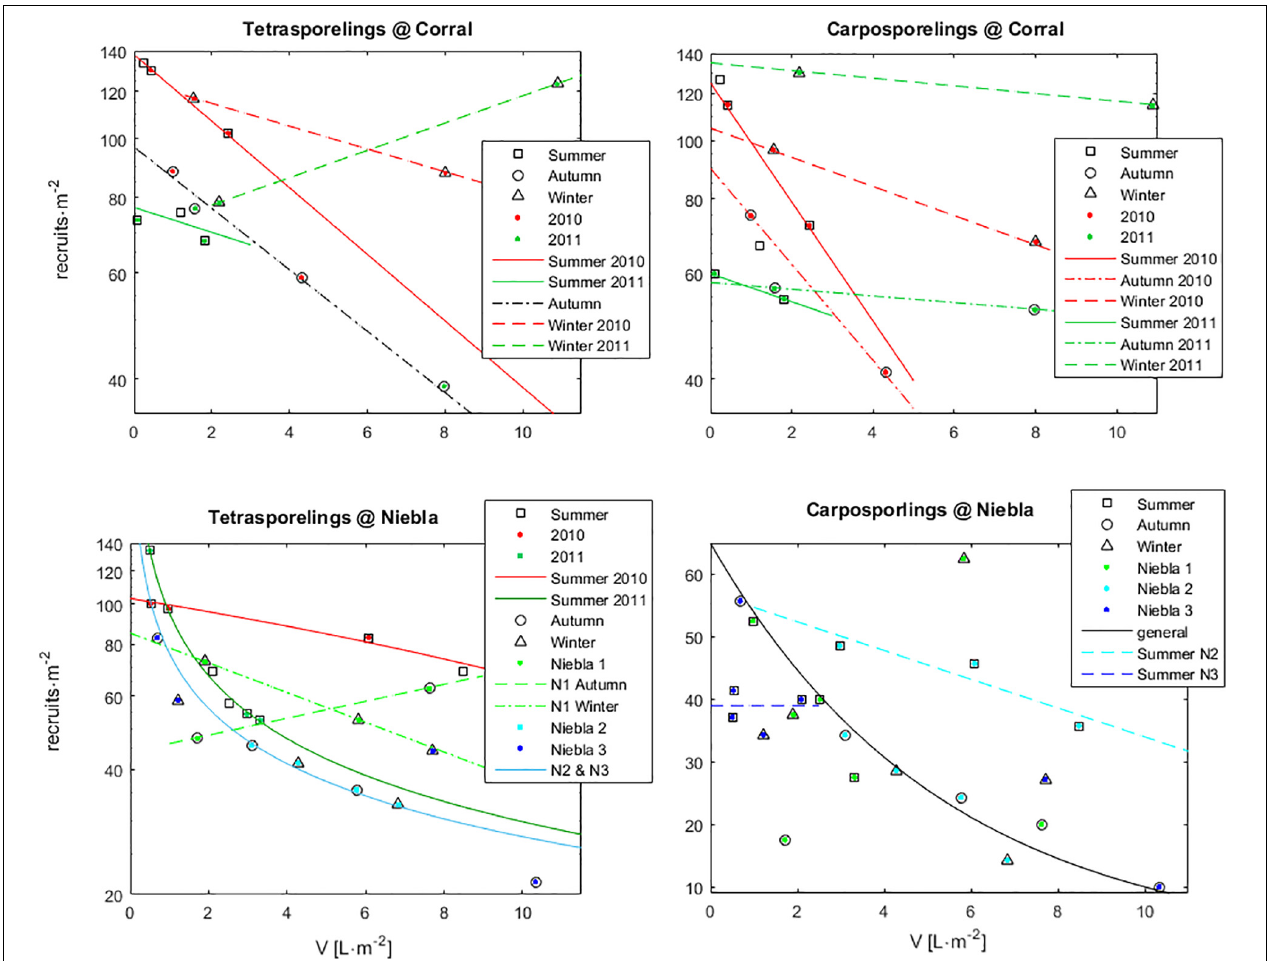
FIGURE 4 | Recruitment algorithm. Recruitment of haploid (Tetrasporelings) and diploid (Carposporelings) germlings at time t, and its dependency on the density of adult fronds (V) at time t-1. Further effects of year, season and location are shown. Plots were Corral 1 (C1), Corral 2 (C2), Niebla 1 (N1), Niebla 2 (N2), and Niebla 3 (N3). Markers represent observations and lines the applied models.